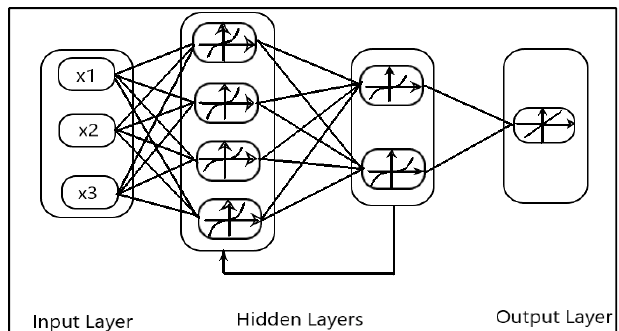
Figure 8. Basic architecture of DL-RNN [40].